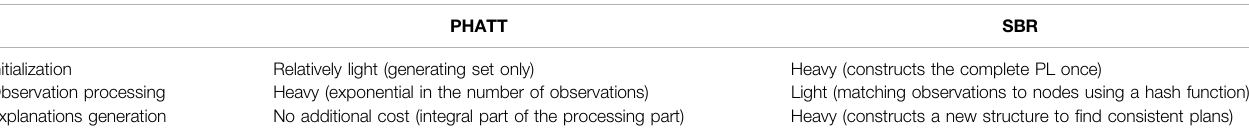
TABLE 1 | Algorithmic components of PHATT and